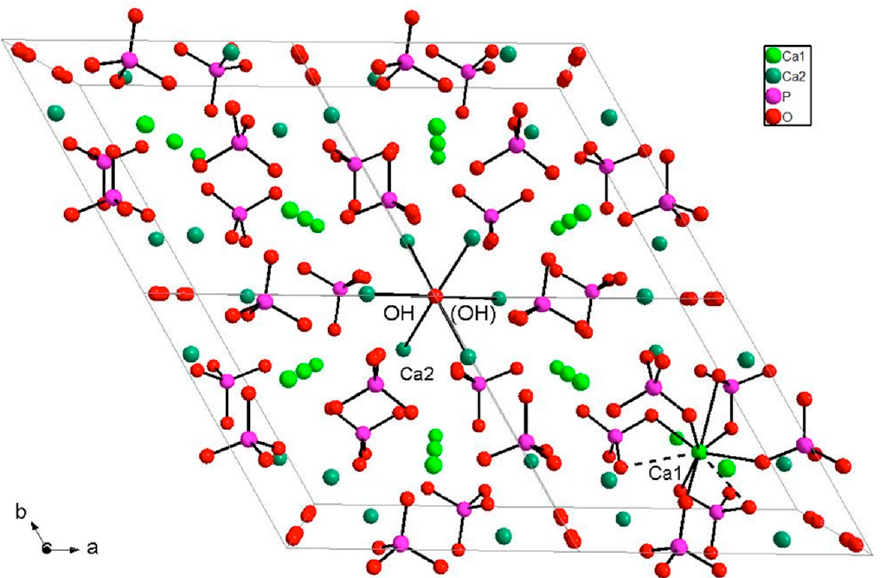
Figure 8. View of a quadruple unit cell of HAp sample, with details of Ca1O 6 metaprisms and Ca2 6 (OH) 2 groups. (OH) groups correspond to O4 atoms. Ca1-O3 bonds over 2.8 Å are dashed for clarity. H atoms are not drawn for clarity.